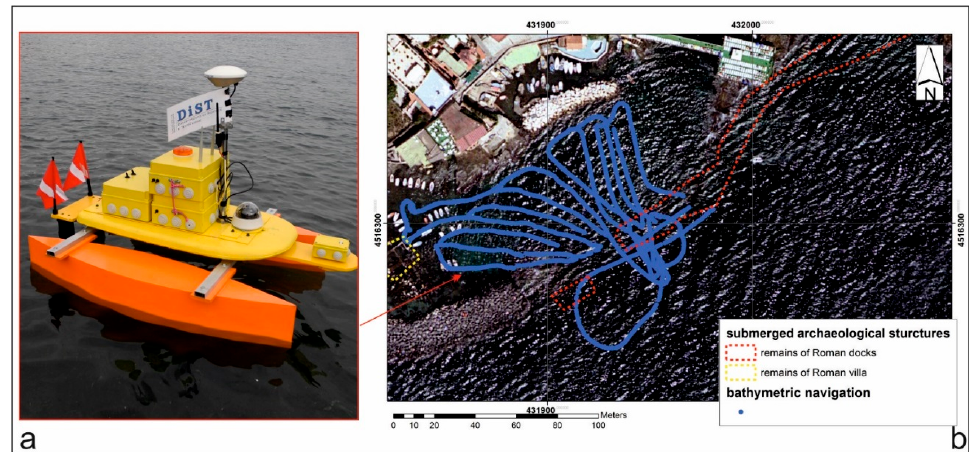
Figure 15. ( a ) MicroVeGA drone prototype #2 used during the survey; ( b ) navigation lines of